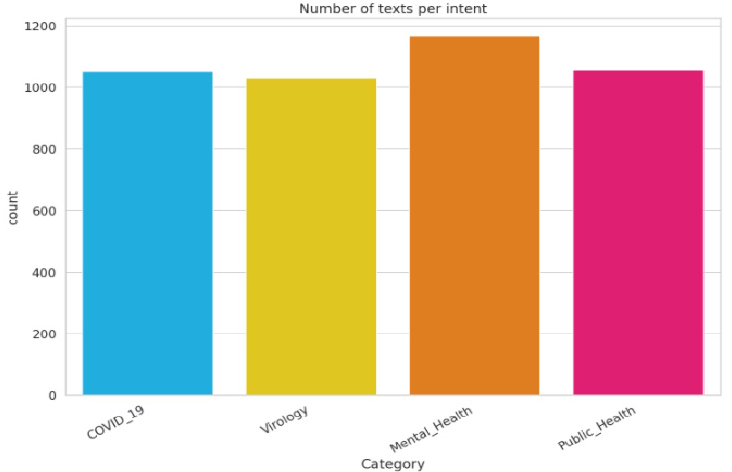
Figure 1. Data repartition in the Cov-Dat-20 dataset. For more details, 4304 rows and 3 columns, 1,013,901 words, 43,123 unique words and 4304 sentences characterize the Cov-Dat-20 dataset.